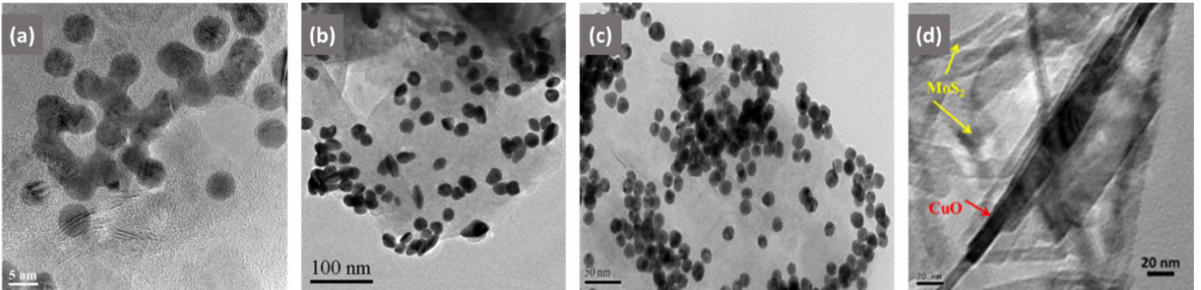
Figure 2. TEM images of ( a ) MoS 2 -Au [69], ( b ) TTR-MoS 2 -Au [80], ( c ) MoS 2 -PEI-Au [81], ( d ) CuO- MoS 2 [82] nanocomposites produced by ex situ functionalization. Figures reproduced with